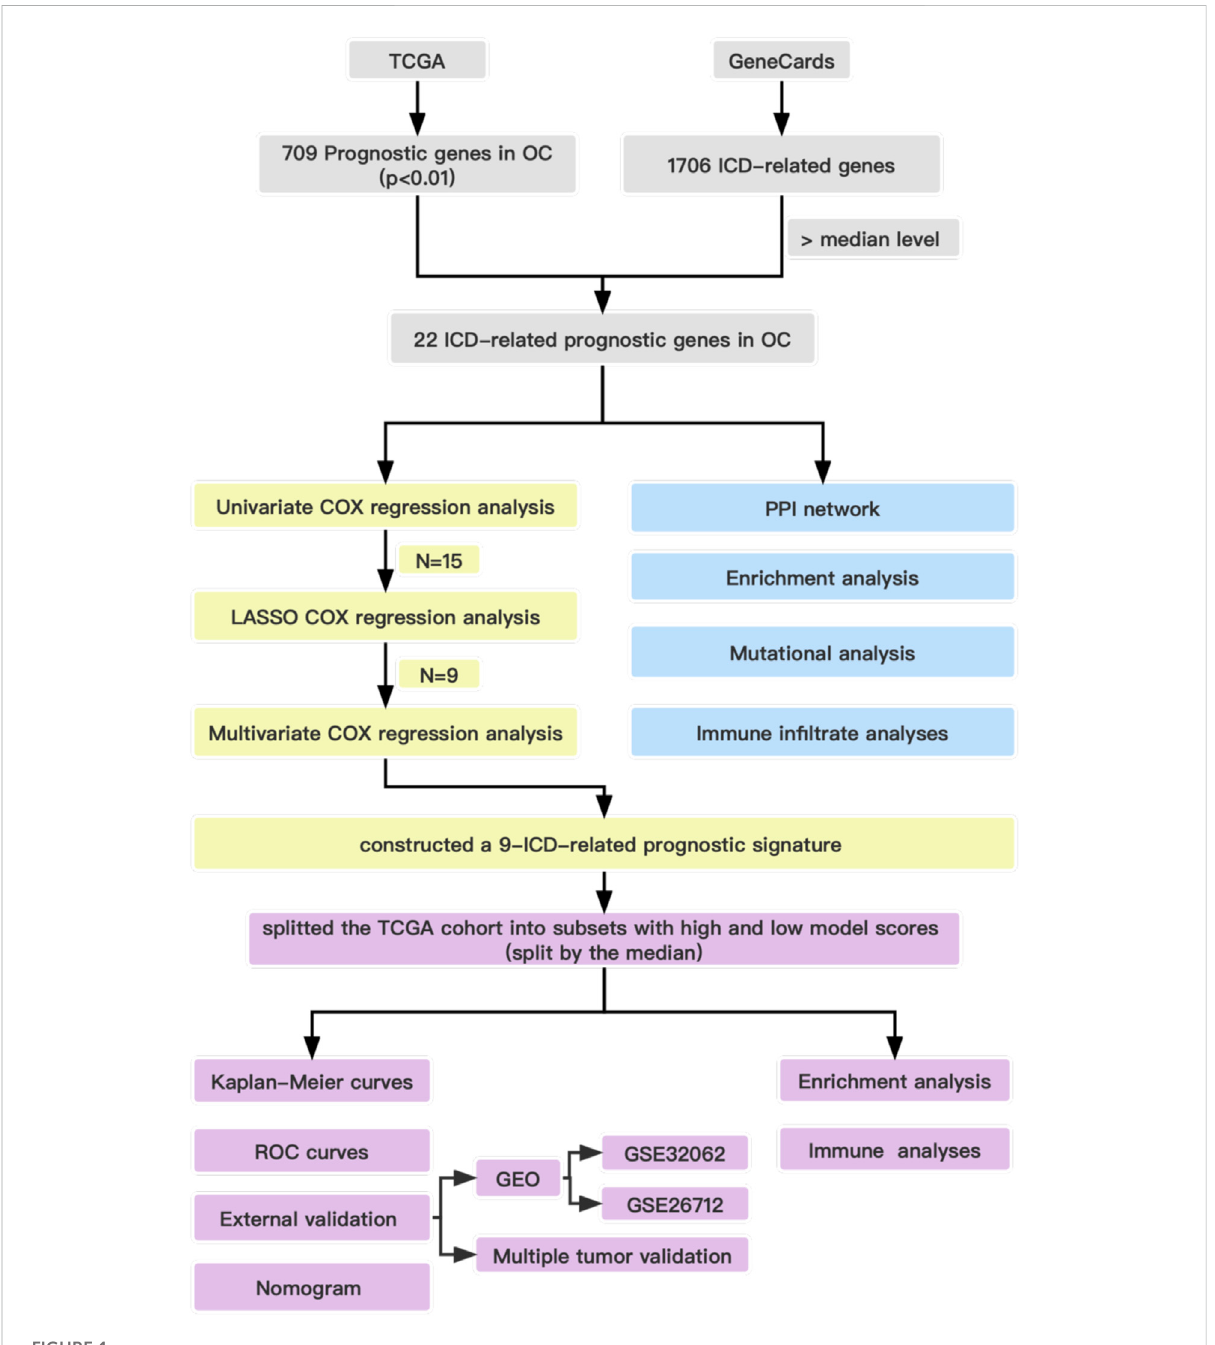
FIGURE 1 Overall fl ow chart of the